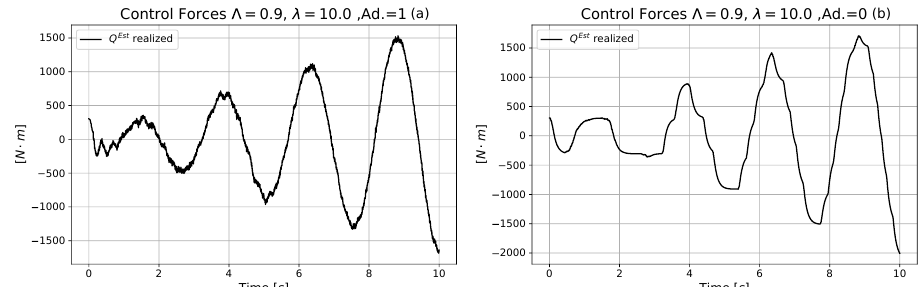
Figure 25. The adaptive abstract rotations. ( a ): Adaptive. ( b ):